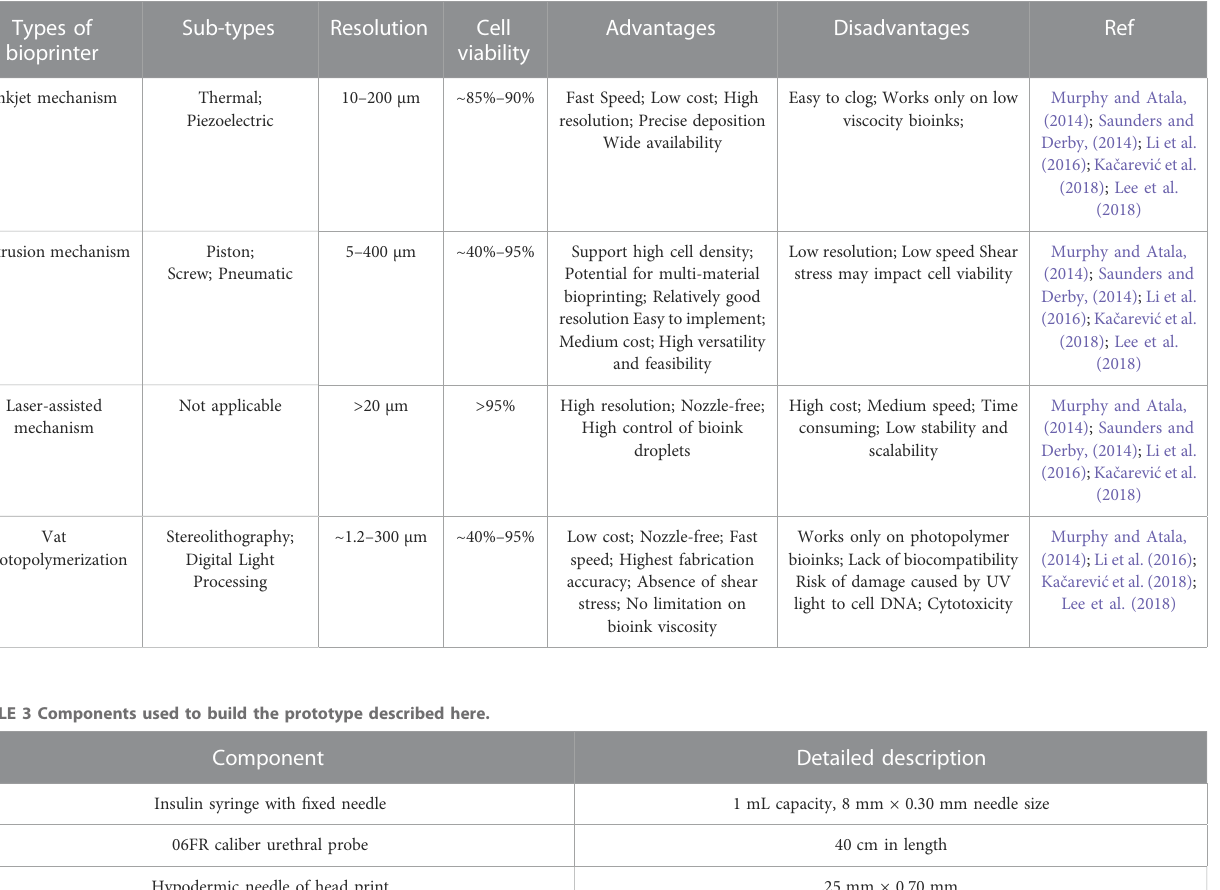
TABLE 2 Technologies applied to 3D bioprinting: general pros and cons.